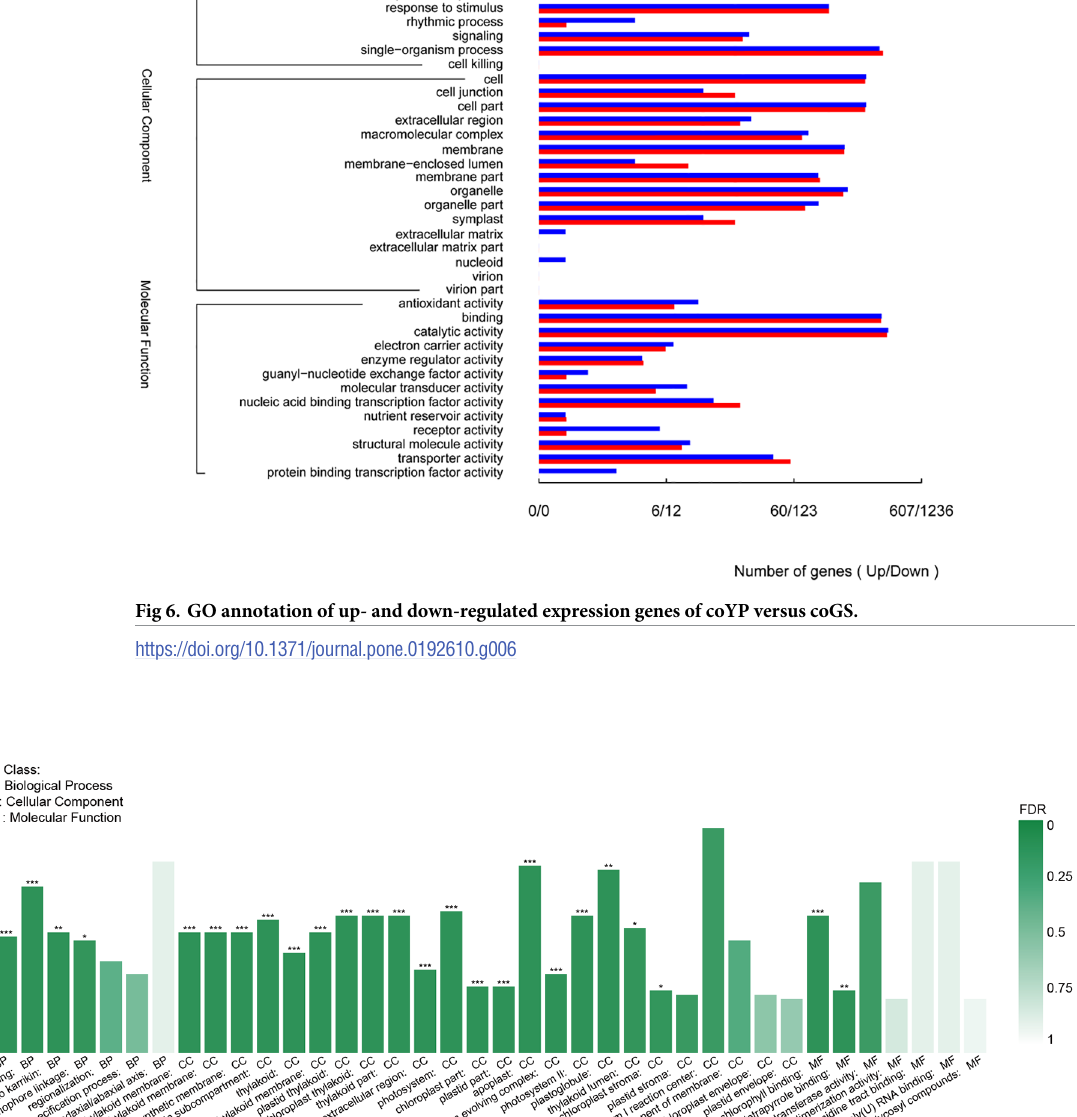
PLOS ONE | https://doi.org/10.1371/journal.pone.0192610 February 16,